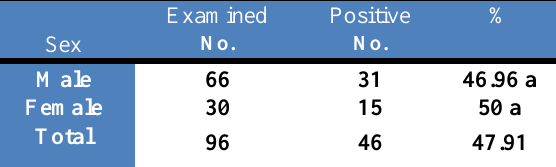
Table, 2: Positive cases of Babesia bovis in Real time-PCR according to animal